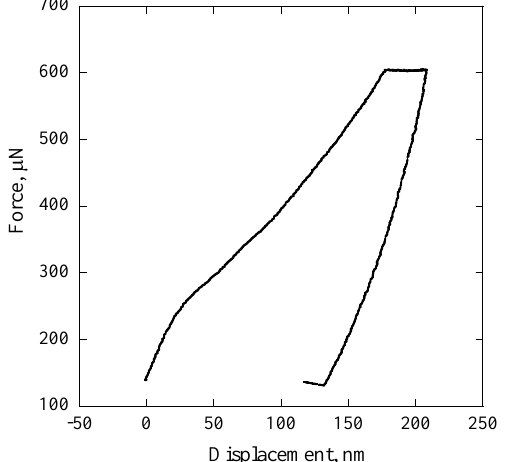
Figure 6. Load–displacement diagram of pp–GT thin film fabricated at 10